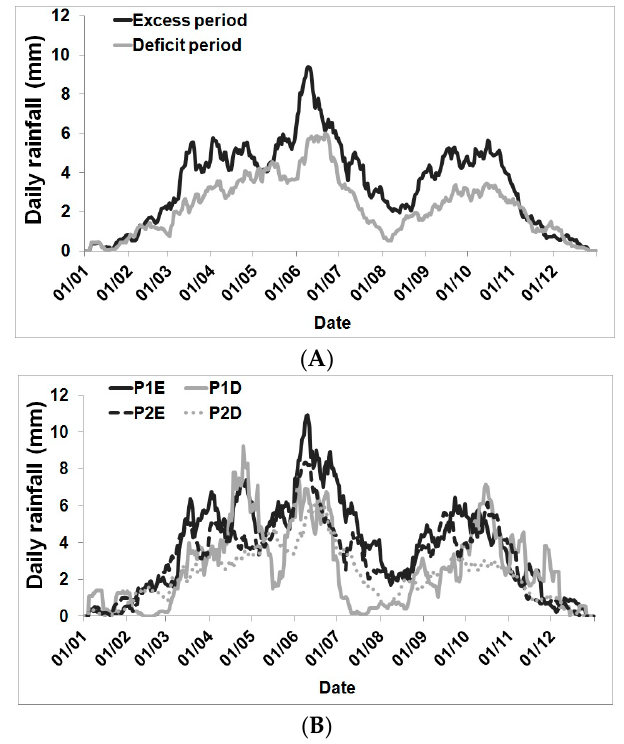
Figure 5. Average seasonal cycle composite periods: ( A ) Excess and deficit. ( B ) Excess (P1E: before 1966 and P2E: after 1966) and deficit (P1D: before 1966 and P2D: after 1966) at the Bongouanou station.